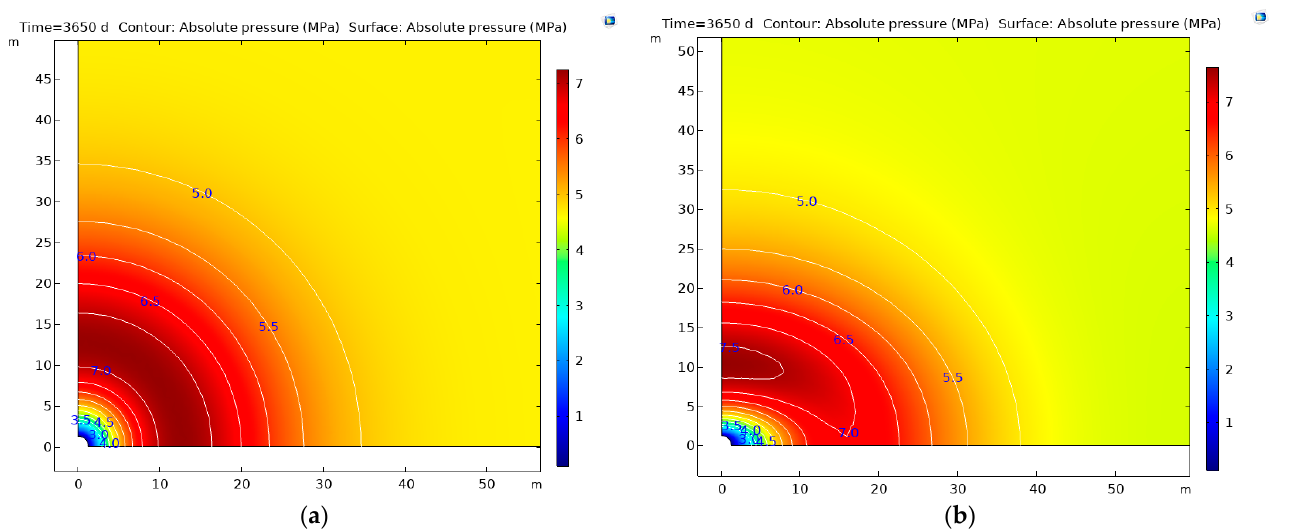
Figure 5. DC variant: distribution of pore pressure at the end of the waiting phase (after 180 days of simulation) ( a ) in the case of isotropic stress conditions and isotropic properties: ( b ) in the case of anisotropic stress and anisotropic properties.